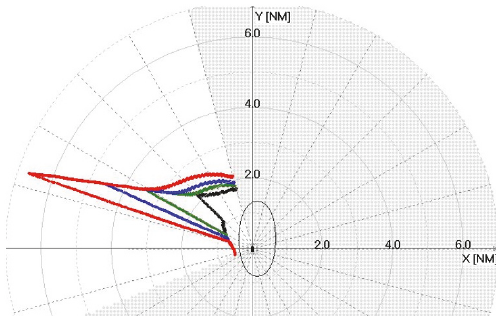
Figure 17: Action lines for stand-on crossing encounter with a target, whose true speed is 18 knots. Assumed are turns to starboard by 40 ∘ (red), 50 ∘ (blue), 60 ∘ (green), and 90 ∘ (black). No speed reduction.